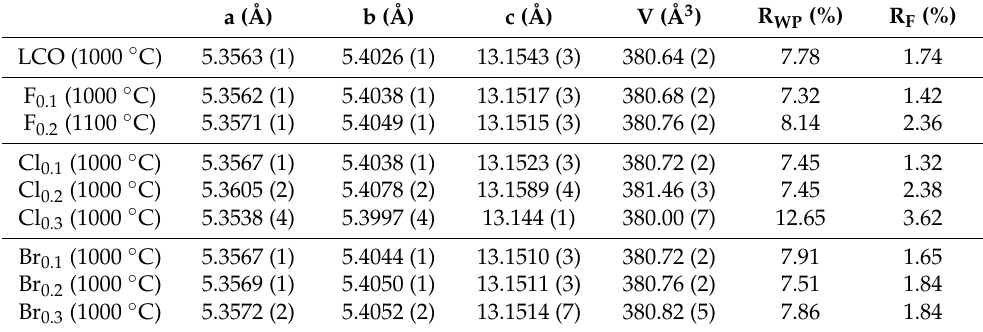
Table 1. Cell parameters, cell volumes and disagreement factors for La 2 CuO 4 − 0.5x A x (A = F, Cl and Br; x = 0–0.3) samples obtained from XRPD data